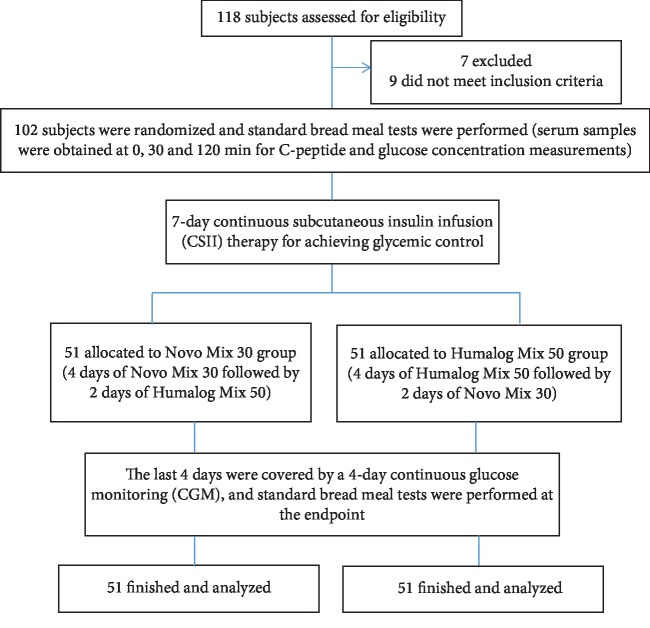
Study flow chart.